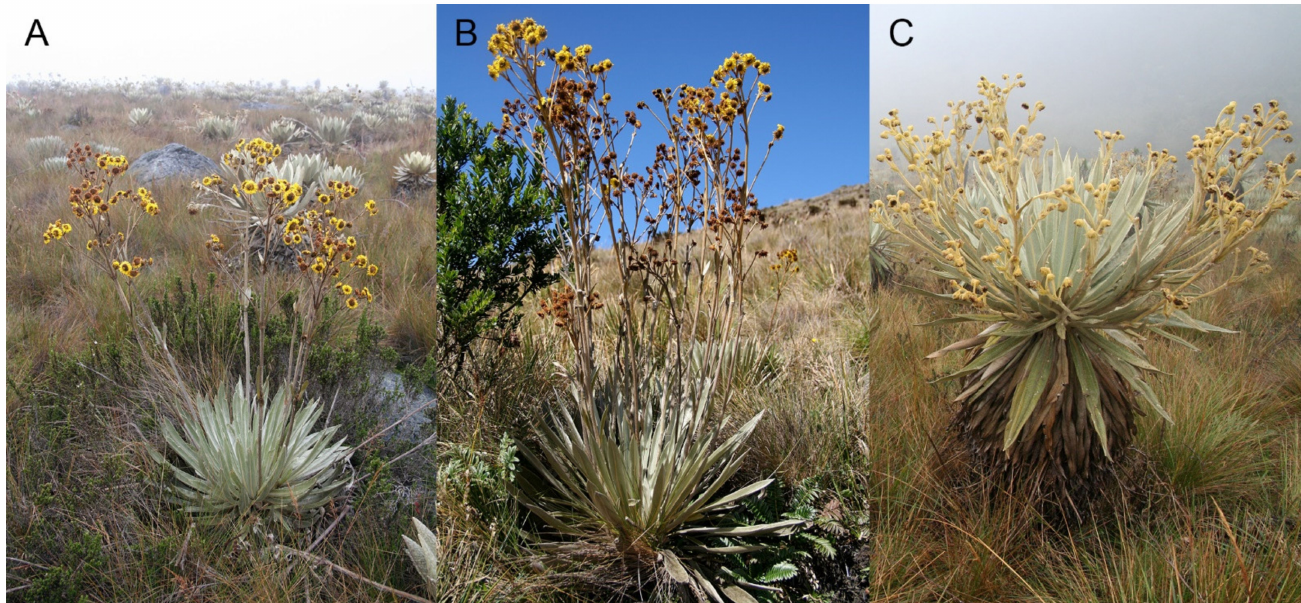
Figure 7. Representative individuals of ( A ) Espeletia argentea Humb. & Bonpl., ( B ) E. boyacensis Cuatrec., and ( C ) E. grandiflora Humb. &